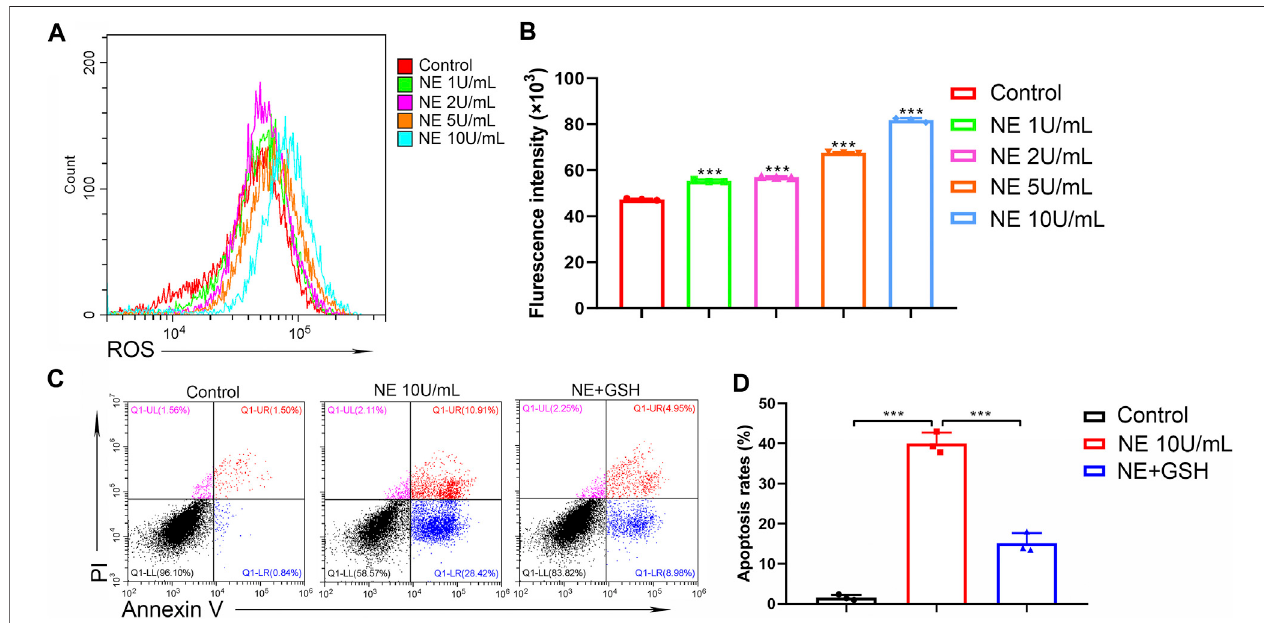
FIGURE5| NeutrophilelastaseinducesROSproductionofchondrocytes. (A,B) ROSlevelsofchondrocytesweremeasuredby fl owcytometry. (A) Representative histogramswereshown. (B) Cellassociatedmeanrelative fl uorescenceintensities. Dataaremean ± SEM; n (cid:1) 3.*** p < 0.001. (C,D) ChondrocytesweretreatedwithNE andGSHfor48 handthenstainedwithannexinV-FITC/PIfollowedby fl owcytometryanalysis. (C) The fl uorescencepatternofannexinV-FITC/PIstainingchondrocytes. (D) Percentages of annexin V positive cells for chondrocytes treated with NE and GSH. Data are mean ± SEM; n (cid:1) 3. *** p <